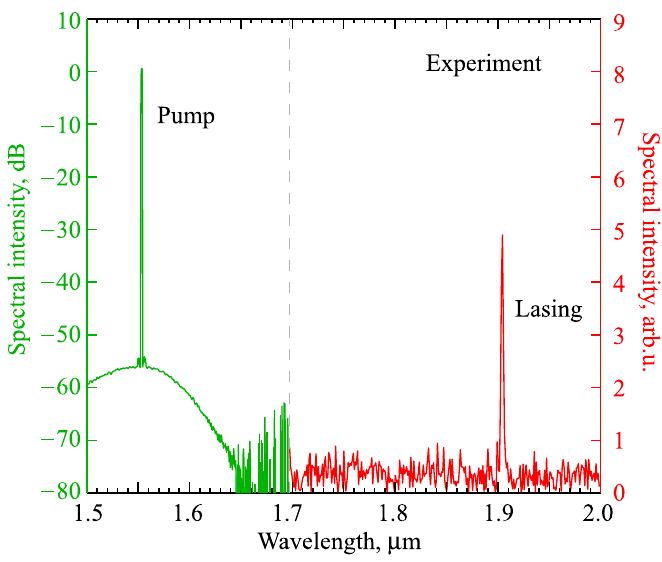
Figure 5. The experimental spectra of the transmitted pump wave (green, left axis, recorded by Telecom OSA in dB scale) and the generated laser wave (red, right axis, obtained using monochromator and PbSe detector in a linear scale).